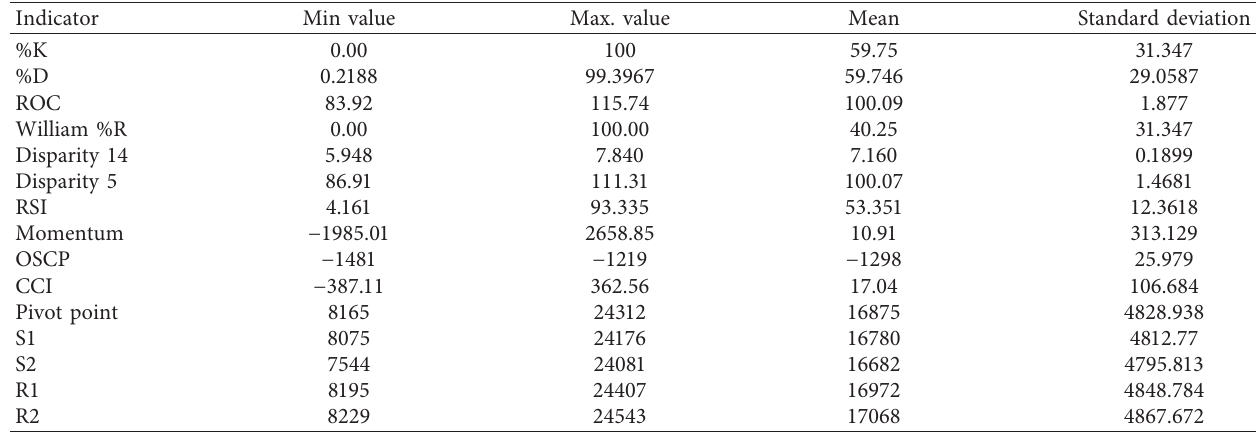
Table 4: Summary statistics of technical indicators for Nikkei 225 index.